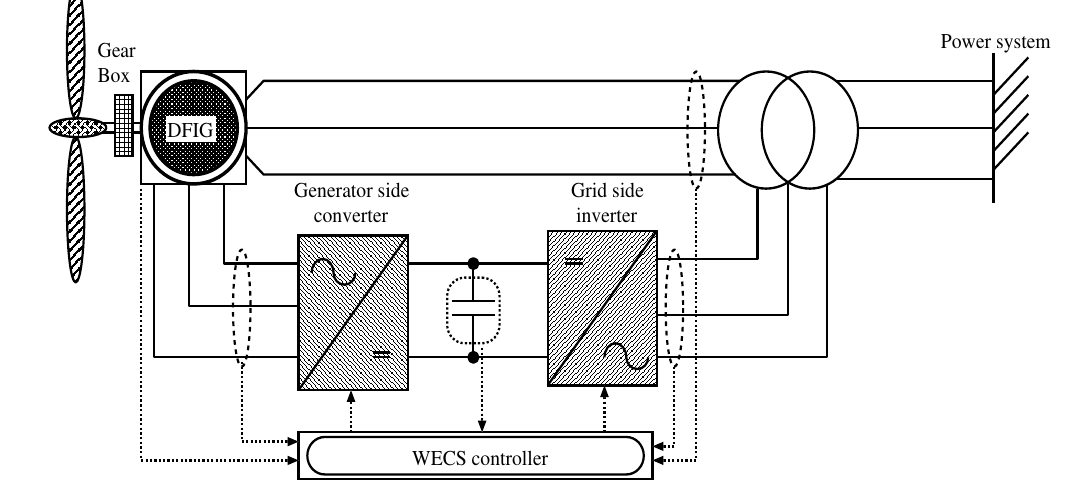
Figure 3. DFIG based wind energy conversion